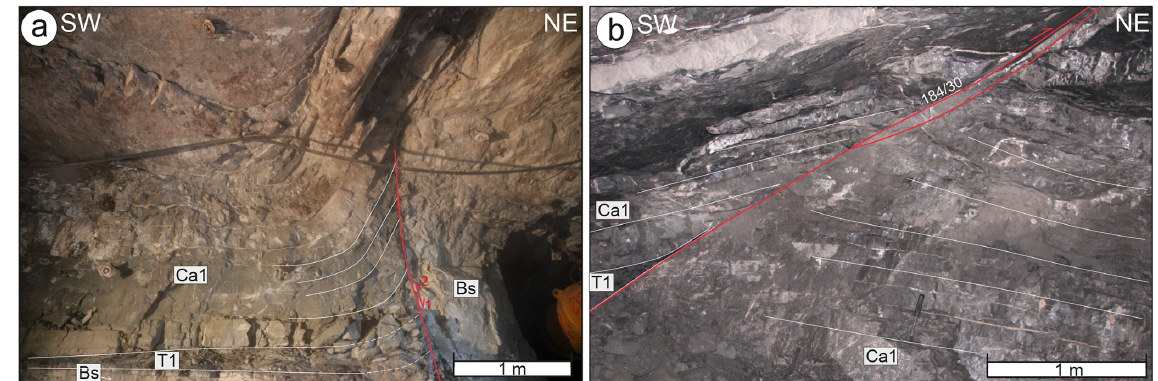
Figure 5. Examples of tectonic structures observed on gallery walls in copper and silver mines on the Fore-Sudetic Homocline at the base Zechstein (upper Permian) ore-bearing formation at the contact with the Rotliegend (lower Permian) strata (location in Fig. 2). (a) Inverted steep fault, originally normal. The inversion caused fault drag of Ca1 Zechstein Limestone. (b) Thrust fault in carbonate rock (orienta- tion recorded as dip direction/dip angle). Abbreviations: Bs – Weissliegend Sandstone (lower Permian); T1 – Kupferschiefer shale (upper Permian); Ca1 – Zechstein Limestone (upper